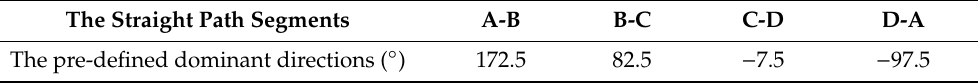
Table 4. The pre-defined dominant directions of the di ff erent straight path